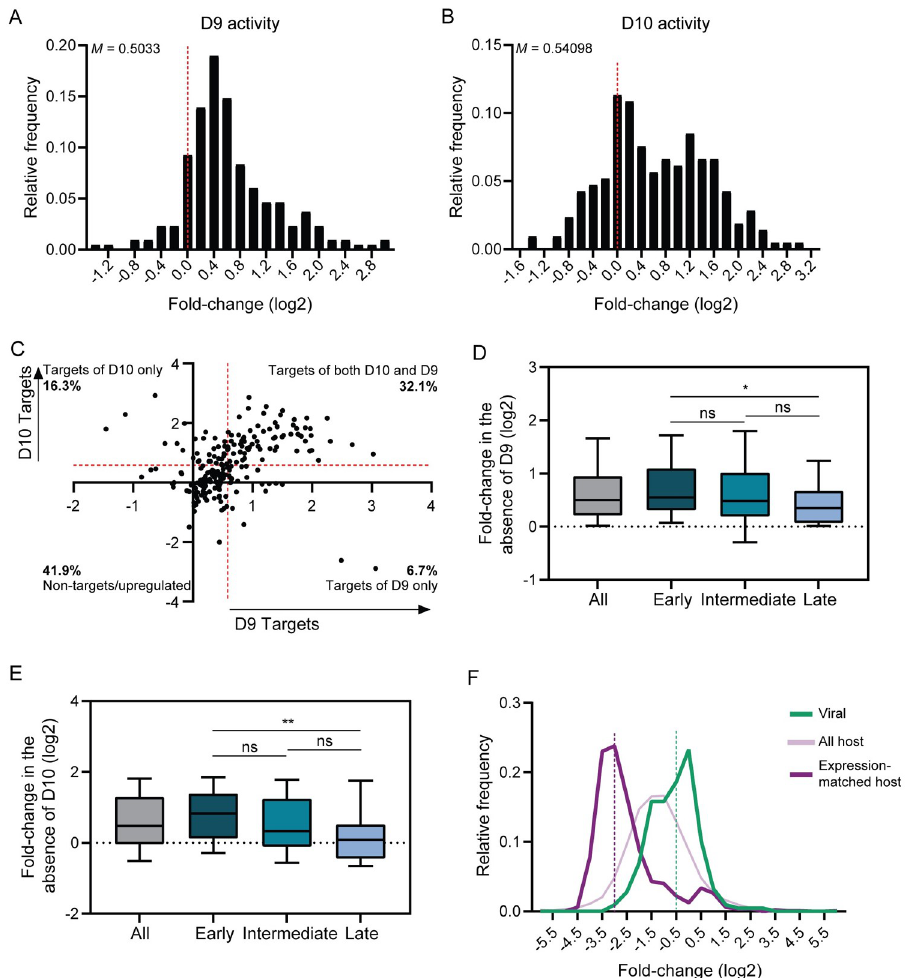
Fig 4. D10 preferentially targets host over viral transcripts. (A) To isolate the activity of D9 on viral transcripts, the fold-change value for each viral transcript was calculated by dividing its expression in cells infected with Δ D9 VACV by its expression in WT VACV at 18 hpi. The histogram shows the frequency distribution for these values, with the dotted red line marking the fold-change value of zero. The median value ( M ) is shown for the plot. (B) To isolate the activity of D10 on viral transcripts, the fold-change value for each viral transcript was calculated by dividing its expression in cells infected with D9muD10mu VACV by its expression in Δ D9 at 18 hpi. The histogram shows the frequency distribution for these values, with the dotted red line marking the fold-change value of zero. The median value ( M ) is shown for the plot. (C) The values calculated from (A) and (B) were plotted against each other. The targets of D9 and D10 were assigned as transcripts upregulated by at least 1.5-fold (0.585 on log2 scale; red line) with the loss of D9 or D10, respectively. The percentage of viral mRNAs falling into each quadrant is shown. (D-E) Viral transcripts from each kinetic class (early, intermediate, late) or in aggregate (all) were plotted against their fold-change in the absence of D9 ( D ) or D10 ( E ). � P � 0.05, �� P � 0.01, Kruskal-Wallis test followed by Dunn’s multiple comparison test versus “Early” genes. The whiskers represent the 10 th and 90 th percentiles. (F) The activity of D10 towards host and viral transcripts was assessed using a similar approach as ( B ), except taking the reciprocal to make the fold-change values negative. A subset of expression-matched host transcripts, defined as highly expressed transcripts within the 90 th -100 th percentile of expression, was also analyzed. The histogram shows the frequency distribution for these values, with the dotted purple and green lines representing the bin where the median value of downregulation lies for expression-matched host and viral genes,